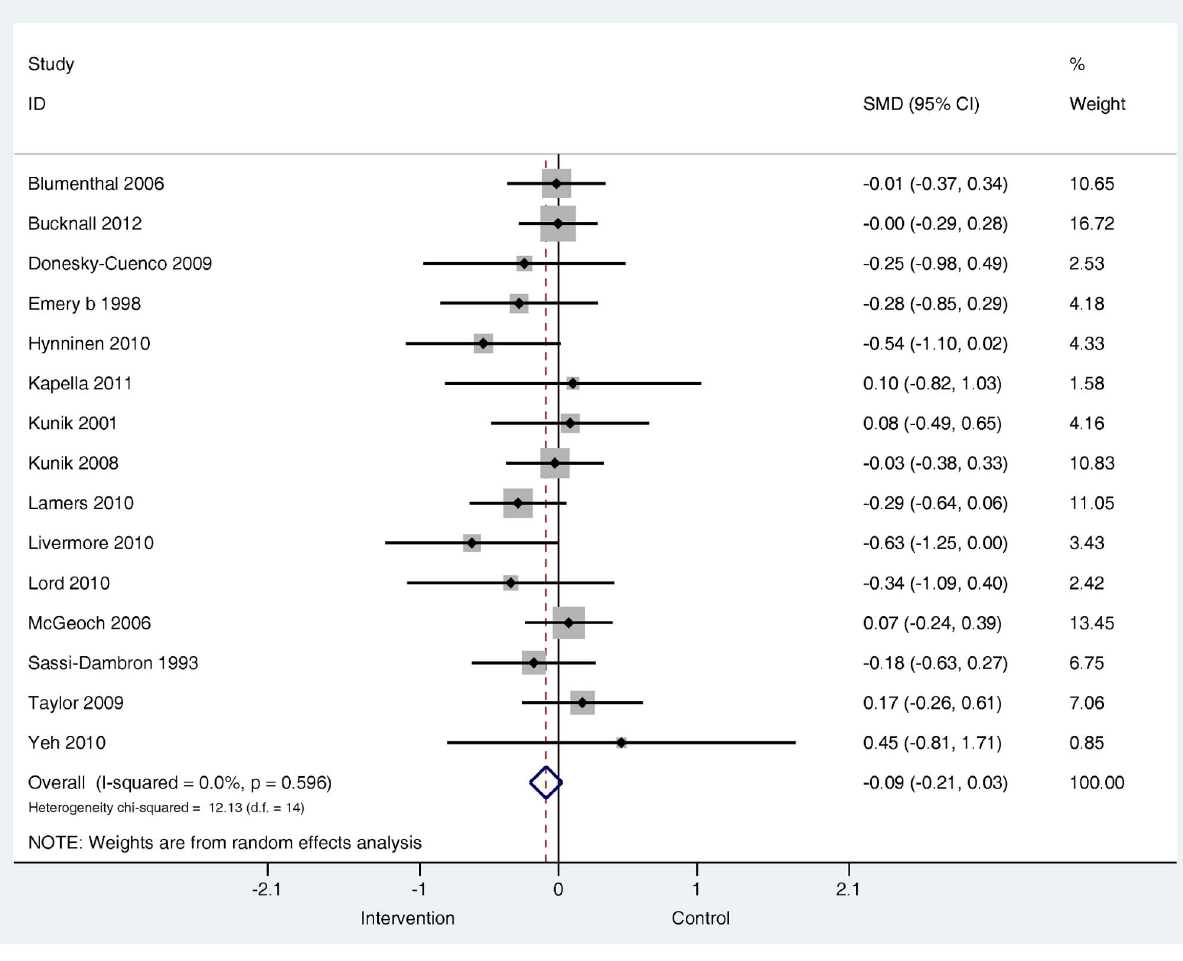
Figure 8. Effects on self-reported symptoms of depression in sub-group of non-exercise based complex interventions. Note: Random effects model used. 95% CI=95% confidence interval; SMD=standardised mean